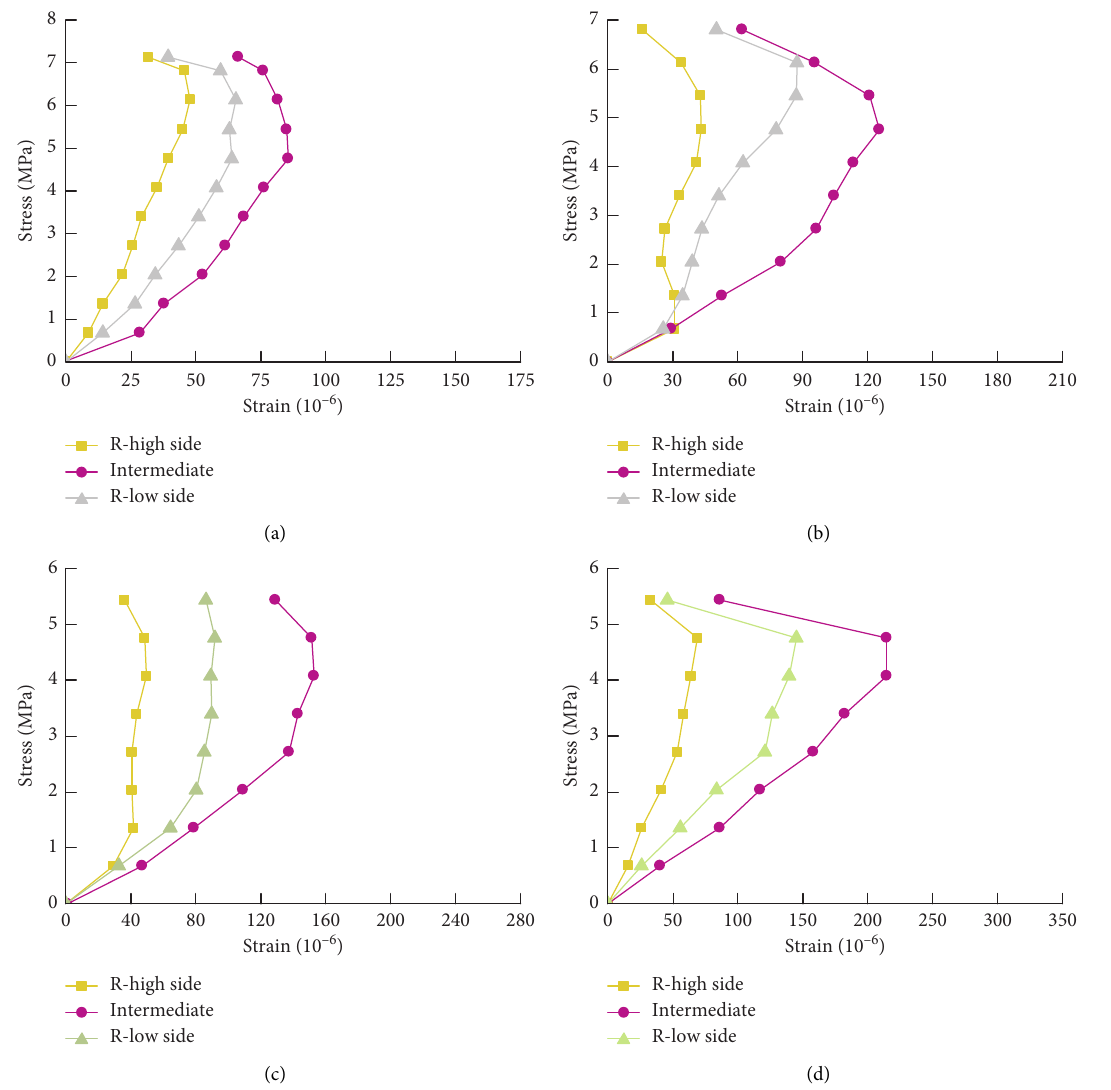
Figure 12: Stress-strain curves of the roof surrounding the rock. (a) 18 ° . (b) 21 ° . (c) 24 ° . (d) 27 °